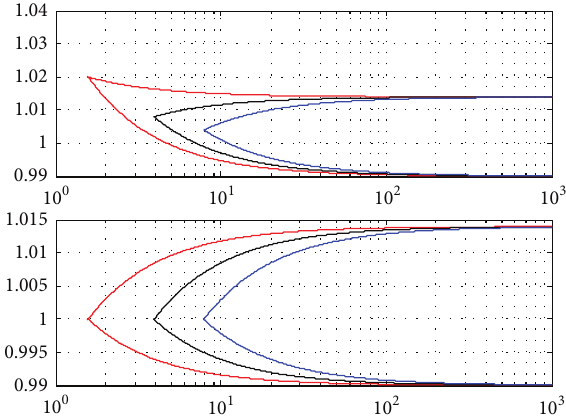
In the top of Figure 7, the left curve is prescribed 𝑐 𝑓 = 0.02 + 0.02 Δ𝑓 , the middle one is prescribed 𝑐 𝑓 = 0.02 + 0.05 Δ𝑓 , and the right one is prescribed 𝑐 𝑓 = 0.02 + 0.1 Δ𝑓 . In the bottom of Figure 7, the left curve is prescribed 𝑐 𝑓 = = 0.05Δ𝑓 , and the right one is 0.02Δ𝑓 , the middle one is 𝑐 𝑓 prescribed 𝑐 𝑓 = 0.1Δ𝑓